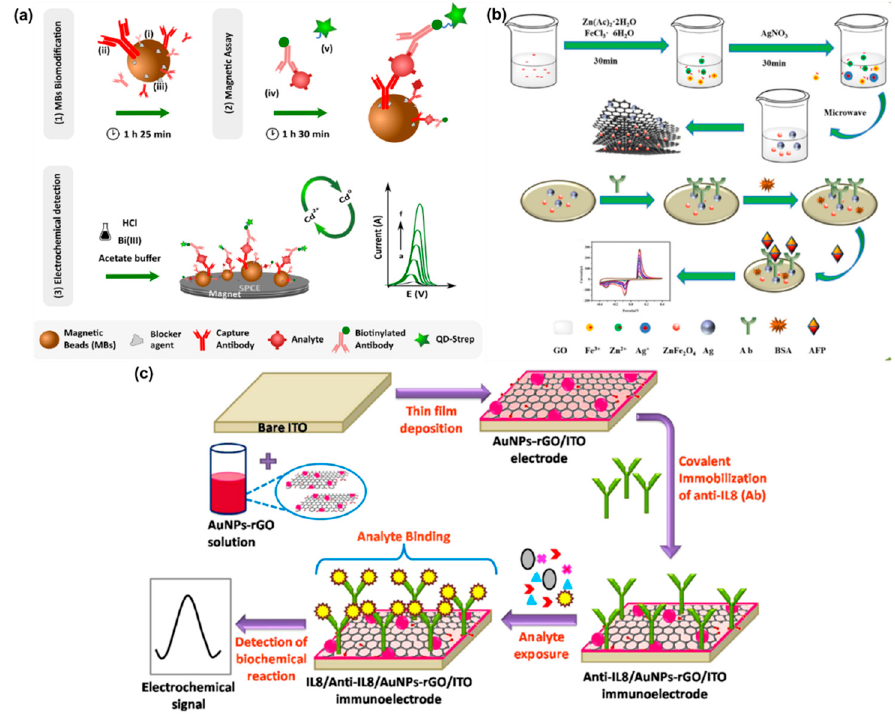
Figure 21. Fabrication and detection mechanism of ECBs for HER2, α -fetoprotein (AFP), and IL-8. ( a ) schematics for the detection of HER2-labeled with CdSe@ZnS QDs through a MagB system [262]. ( b ) synthesis and mechanism of label immunosensor for the sensitive detection of AFP [278]. ( c ) step-by-